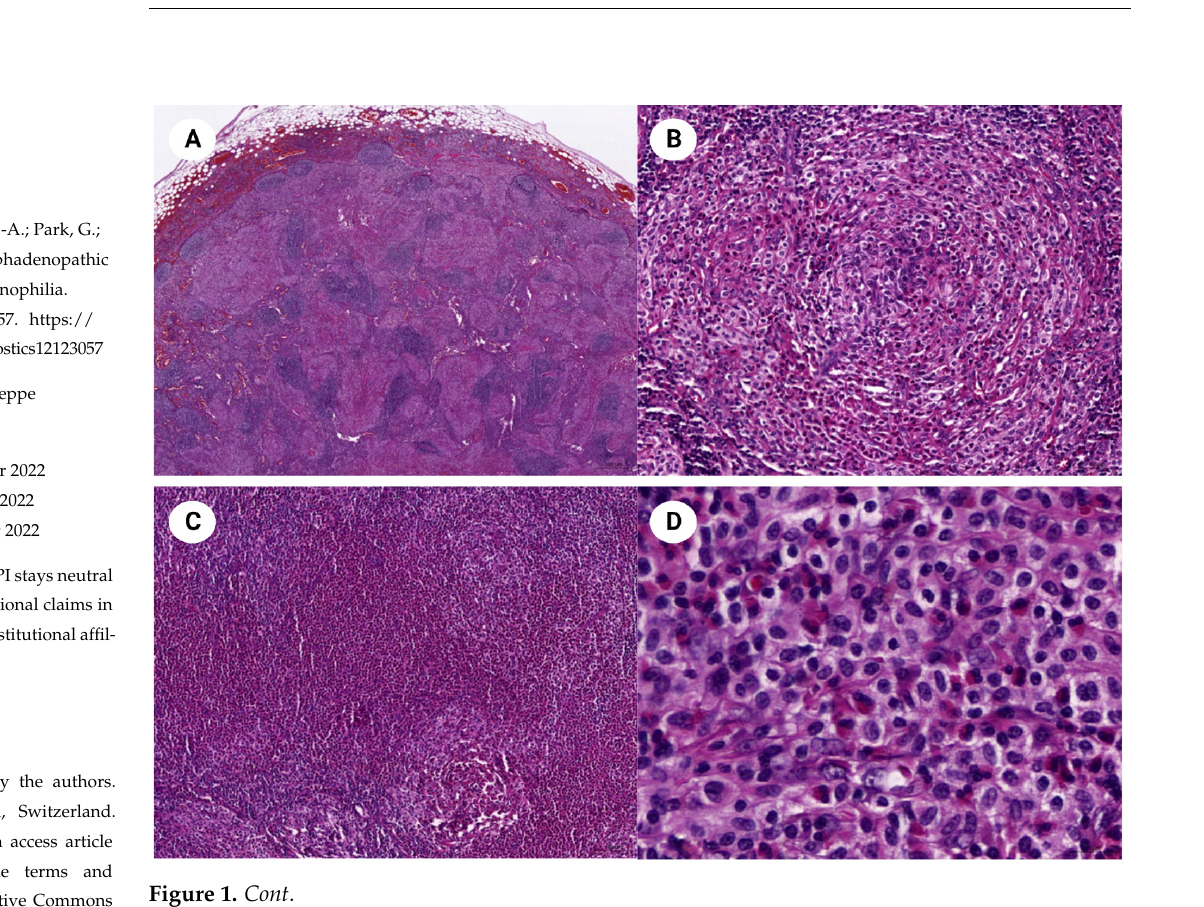
Figure 1. The lymph node demonstrates an interfollicular and sinusoidal proliferation of pale oval cells and abundant eosinophilic aggregates ( A , H&E stain, ×20). It has a granuloma-like pattern with delicate sclerosis ( B , H&E stain, ×200) and eosinophilic microabscesses ( C , H&E stain, ×100). The neoplastic cells have medium-sized with clear or pinking moderate cytoplasm. The nucleus of some cells shows a vesicular nuclear membrane and distinguishable nucleoli ( D , H&E stain, ×630). The neoplastic cells are confirmed as mast cells expressing tryptase ( E , ×200) and having basophilic cy- toplasmic granules ( F , toluidine blue stain, ×630).